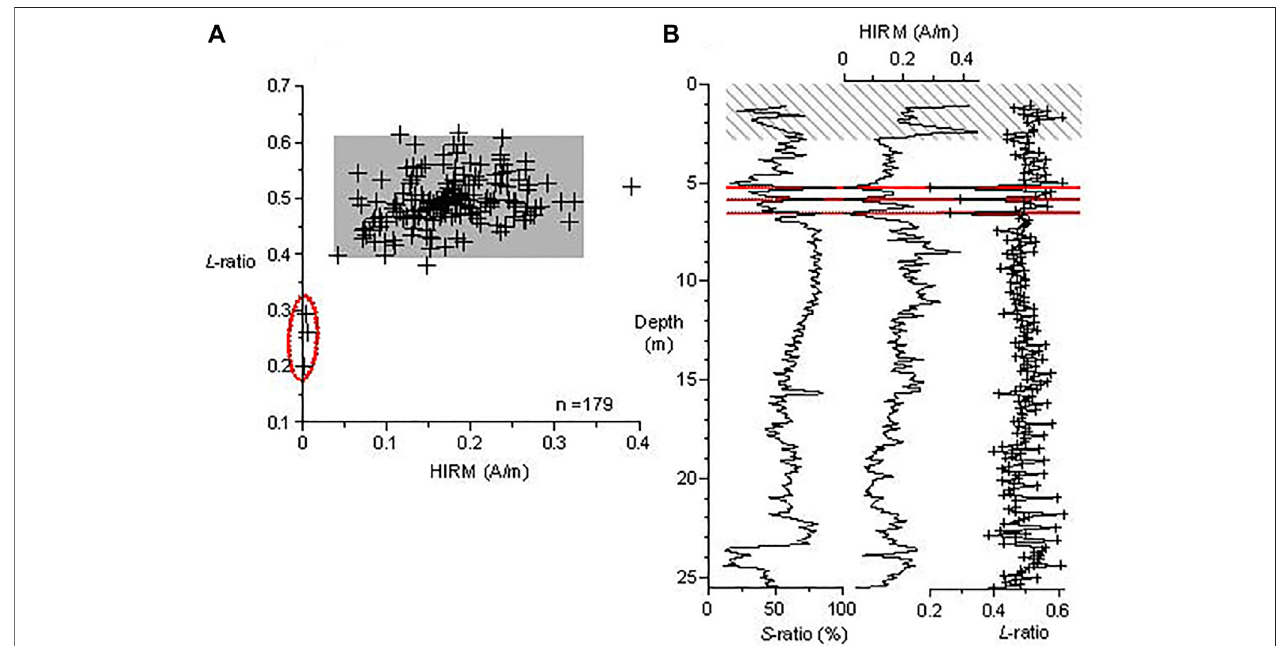
FIGURE 5 | Relationship between L -ratio and HIRM, and down-core variations of S -ratio, HIRM, and L -ratio. Red dotted lines (in B ) indicate three depths with low values in the L -ratio pro fi le, referring to symbols plotted within the red-dotted ellipse (in A ).